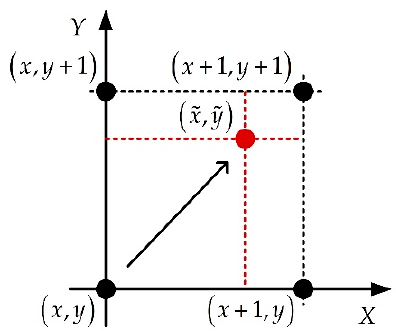
( ) , x y is the 2D coor-